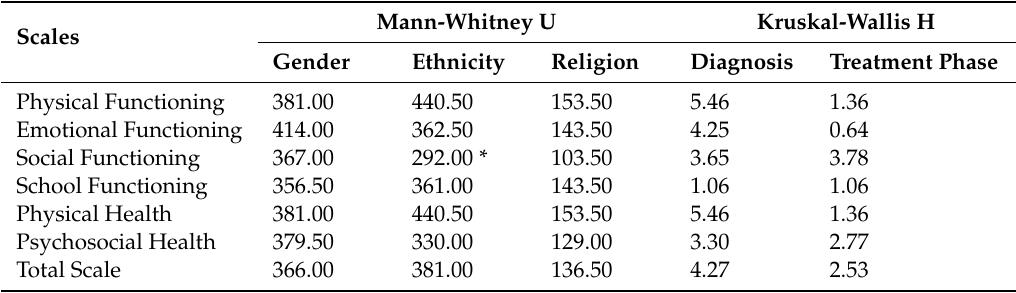
Table 3. Mann-Whitney U Tests for Gender, Ethnicity, and Religion, and Kruskal-Wallis Tests for Diagnosis and Treatment Phase on Pediatric Quality of Life Inventory (PedsQL)